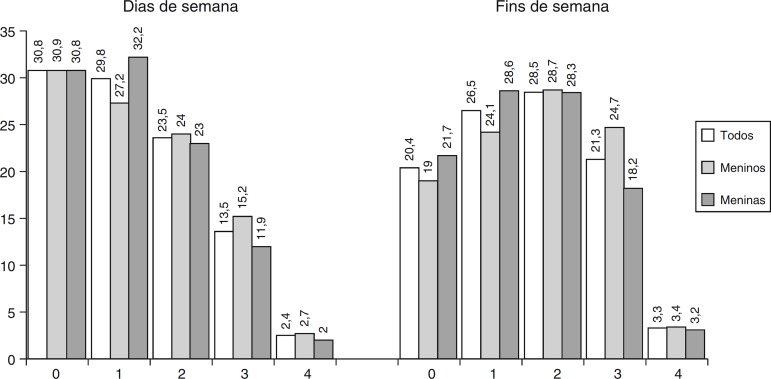
Acúmulo de comportamento sedentário em duas ou mais horas por dia em
diferentes indicadores de comportamento sedentário, Pelotas-RS Brasil, 2013,
n=8.661.